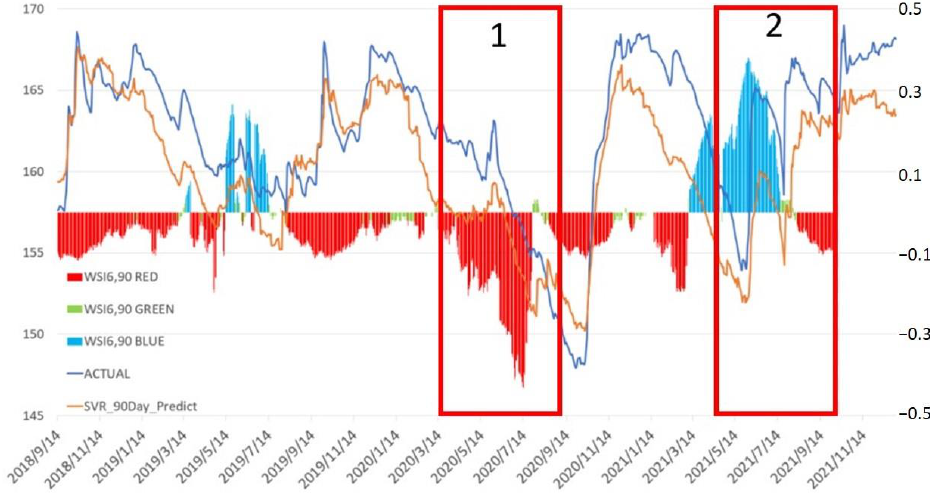
Figure 10. Analysis result of WSI 6,90 .